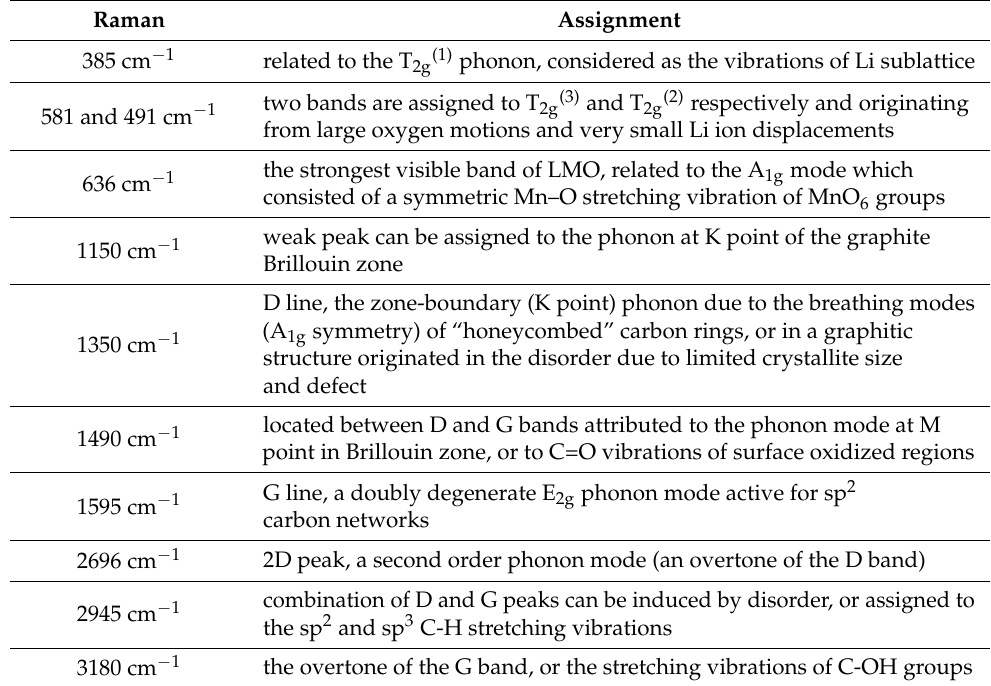
Table 2. The band assignment of spectra of LMO/1- 5%wt. GO.